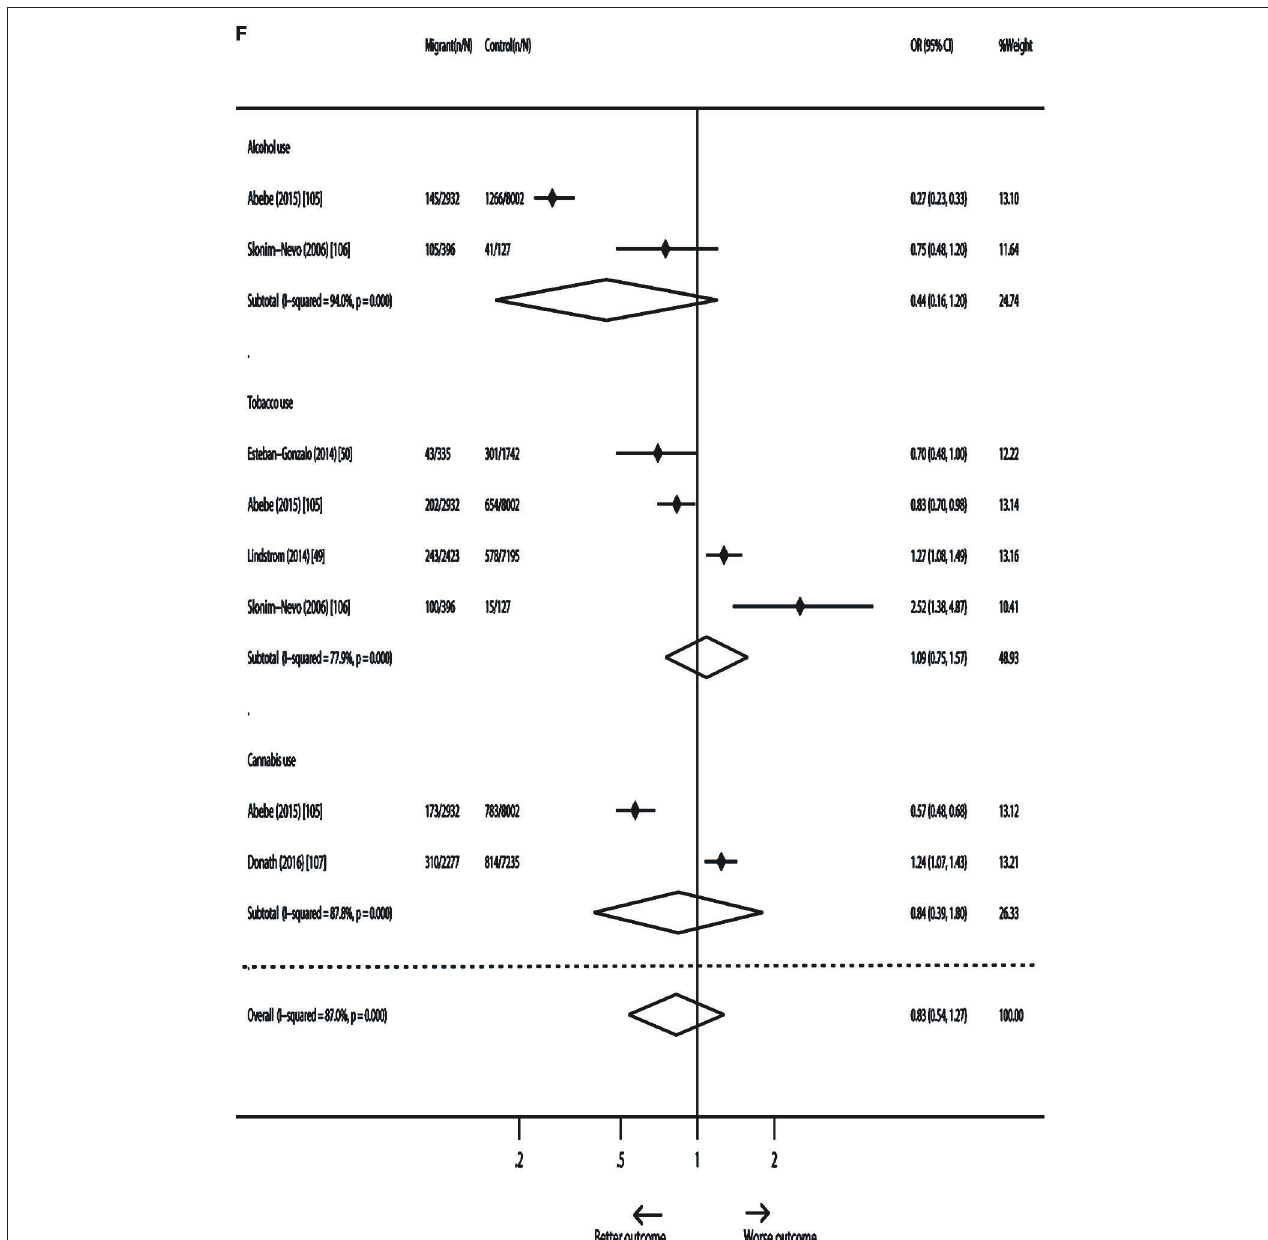
FIGURE 2 | Forest plot of ORs for health outcomes. (A) Birth outcome. (B) Nutrition. (C) Physical health. (D) Mental health. (E) Death. (F) Substance